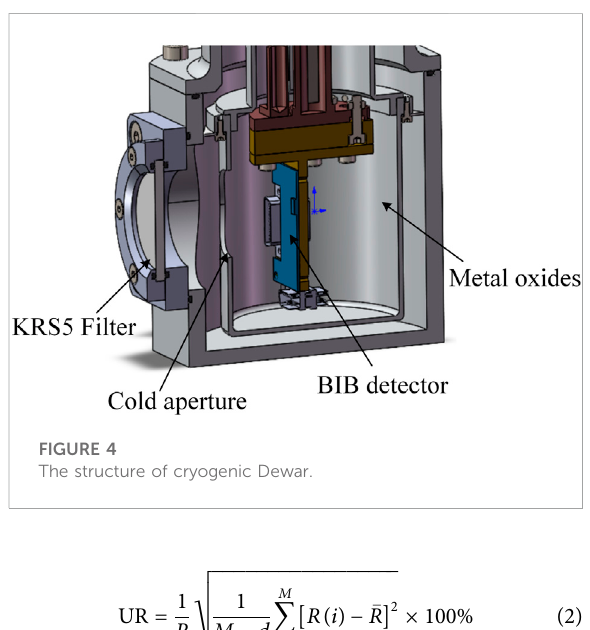
FIGURE 4 The structure of cryogenic